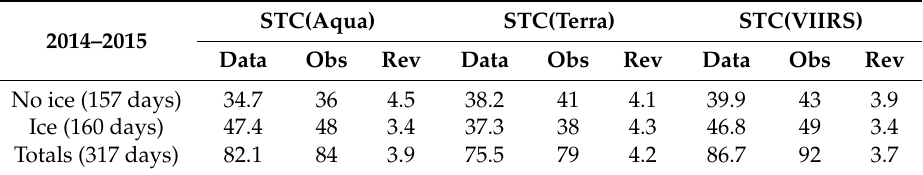
Table 3. Comparison of cloud mask statistics over river grid cells, categorized by ice cover, obtained from the STC algorithm. Data: see Equation (2); Obs: number of days on which at least one grid cell was observed; Rev: see Equation (1), in days. The number in brackets of the first column specifies how many days corresponded to “no ice” or “ice”, as per the discharge quality